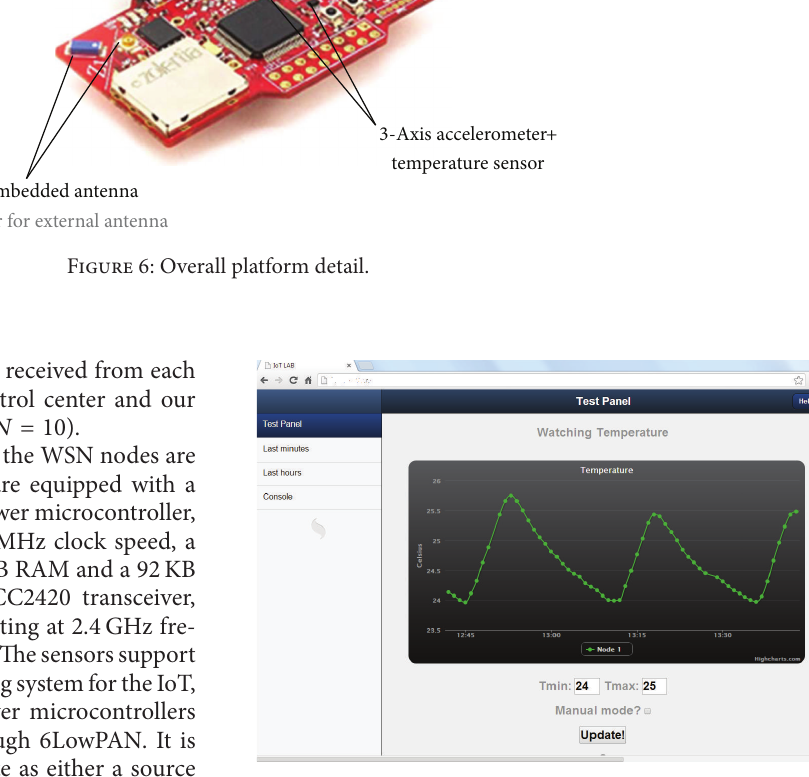
Figure 7: Google Chrome screenshot of the web